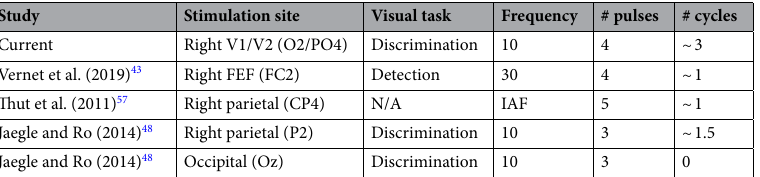
Table 2. Comparison with previous short-burst TMS-EEG entrainment studies. The stimulation site lists the target brain region along with the closet EEG electrode. The visual task is the task concurrent to TMS and control conditions. Most studies focus on the intrinsic alpha oscillations in the occipital or parietal cortices except one on the intrinsic beta oscillations in the frontal cortex. The number of cycles indicates how long the entrainment effect lasts following the last TMS